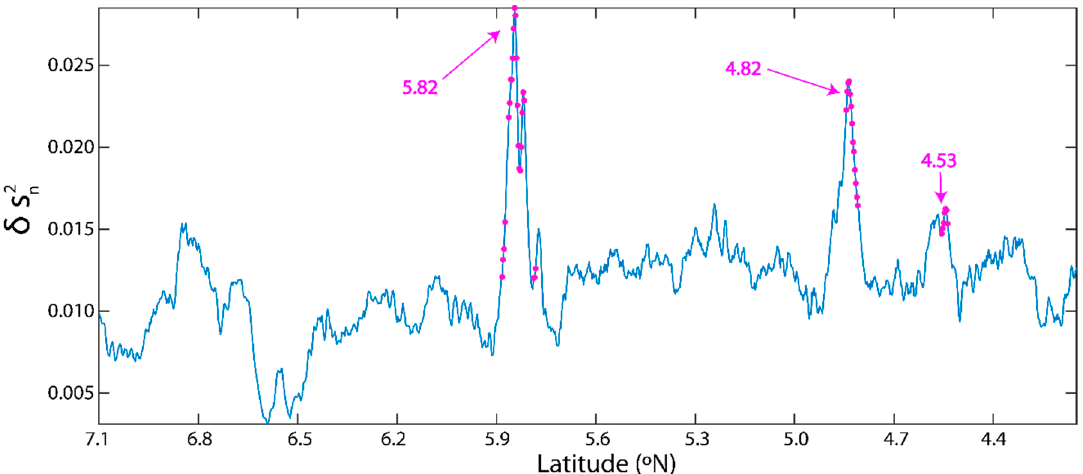
Figure 8. Differenced mean square slope record calculated from the dual-frequency SRAL altimeter with the result of the automatic algorithm designed in this paper for relative orbit 095 of cycle 018, dated 25 May 2017.